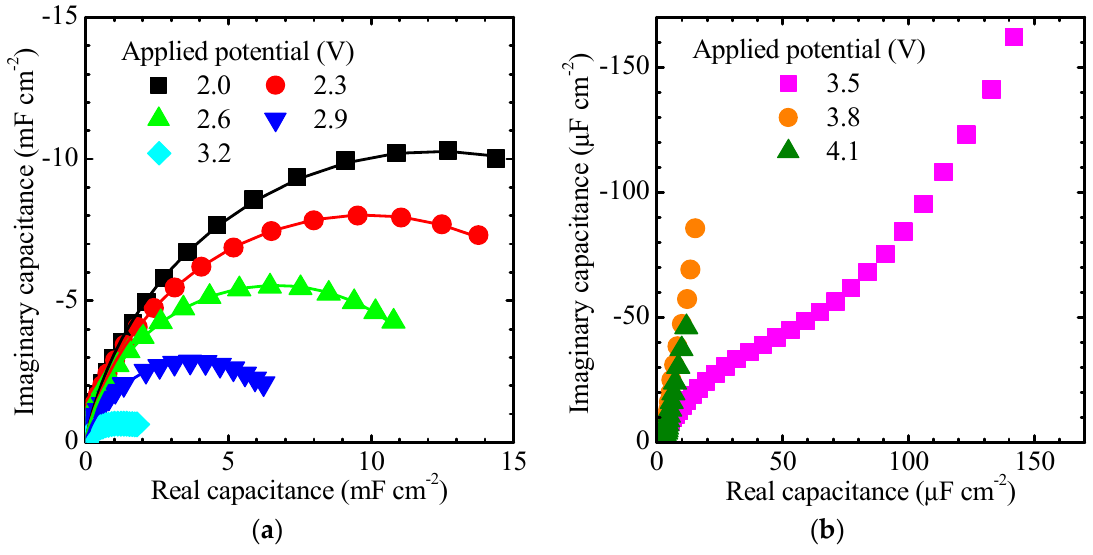
Figure 4. Imaginary capacitance vs. real capacitance for a ~300-nm-thick HWO x film measured in a Li + -containing electrolyte: ( a ) at low potentials; ( b ) at high potentials. Spectra were measured in the frequency range 10 mHz to 100 kHz at the shown potentials vs. Li/Li + . Symbols indicate measured data and solid lines show the semicircle fit.